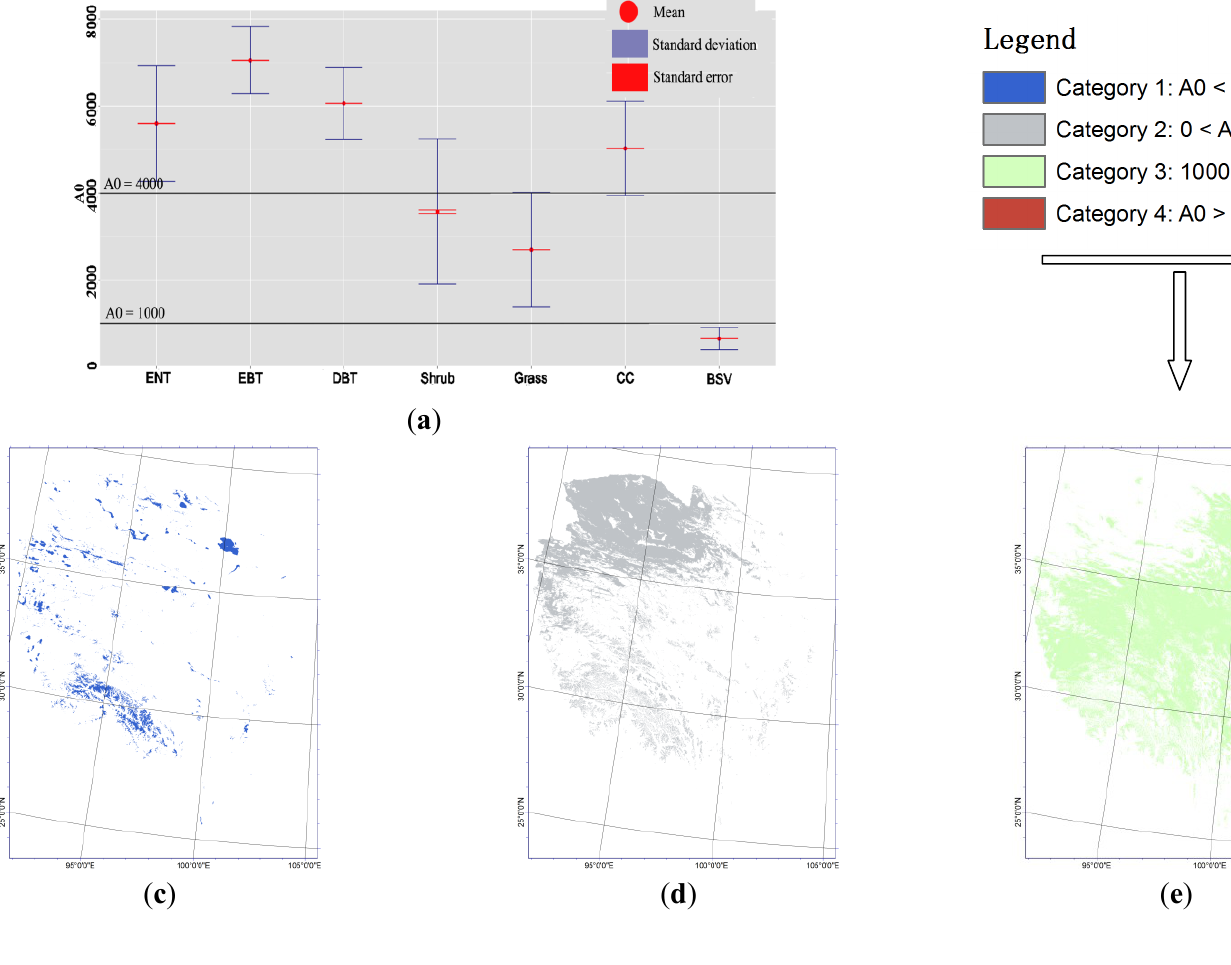
; ( c ) category1 with 0